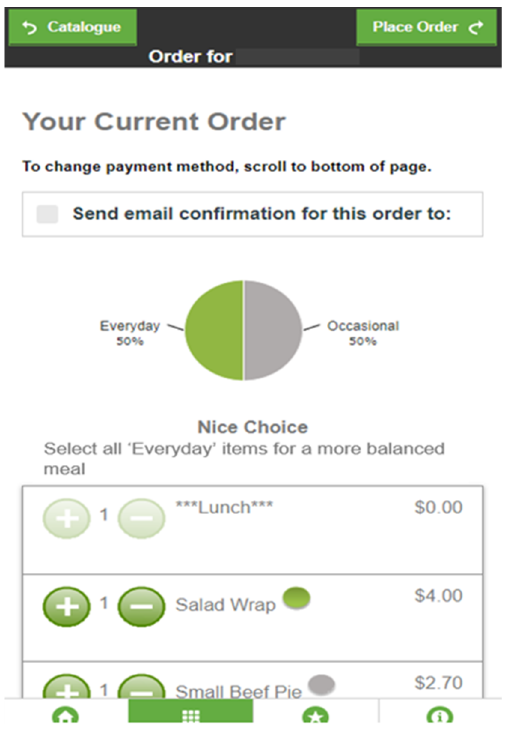
Figure 1. Feedback screen showing pie graph feedback.